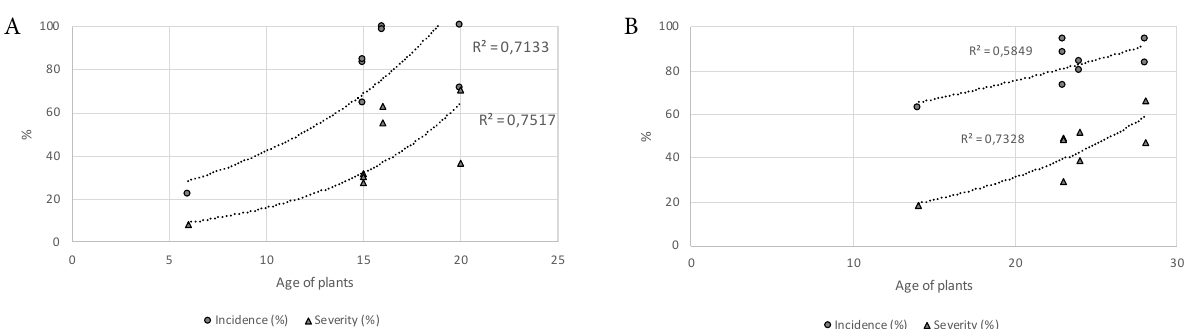
Figure 3. Relationships between vineyard age (‘Cabernet Sauvignon’) in the O’Higgins Region and the incidence and severity of Botry- osphaeria dieback in A) spring 2010; and B) spring